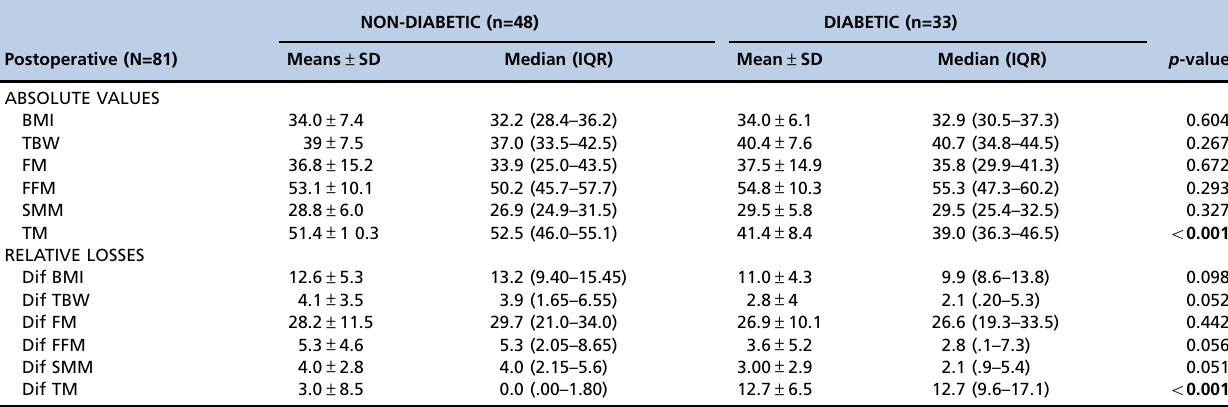
Table 3 - Results of body composition evaluated by bioimpedance analysis 1 year after Roux-en-Y gastric bypass comparing non- diabetic and diabetic (T2DM) patients with severe obesity.